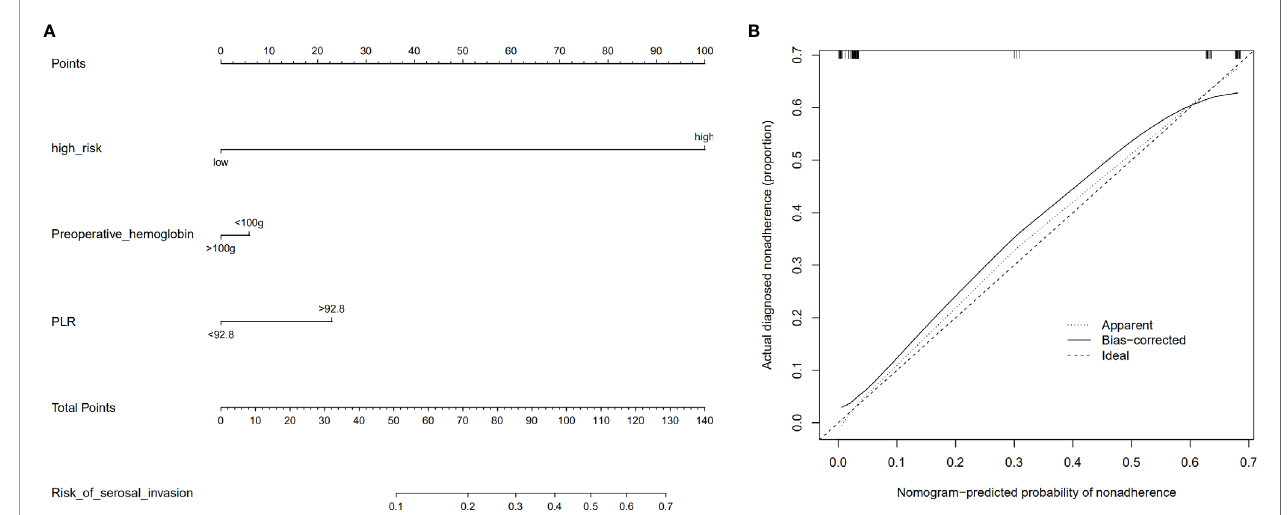
FIGURE 2 | Radiomic nomogram based on radiologic tumor invasion score and clinical factors and a calibration curve of the radiomics nomogram in the training cohort. (A) The nomogram consists of three indicators, namely, radiation tumor invasion score, preoperative hemoglobin, and platelet and lymphocyte ratio. By adding the three scores, the nomogram can quickly calculate the probability of serosal invasion. (B) The calibration curve depicts the consistency between the predicted values of serosal invasion and the actual observed values. The y-axis represents the actual value. The x-axis represents the predicted value. The more consistent the dotted and solid lines are, the better the predictive power of the model is. PLR, ratio between platelet and lymphocyte.